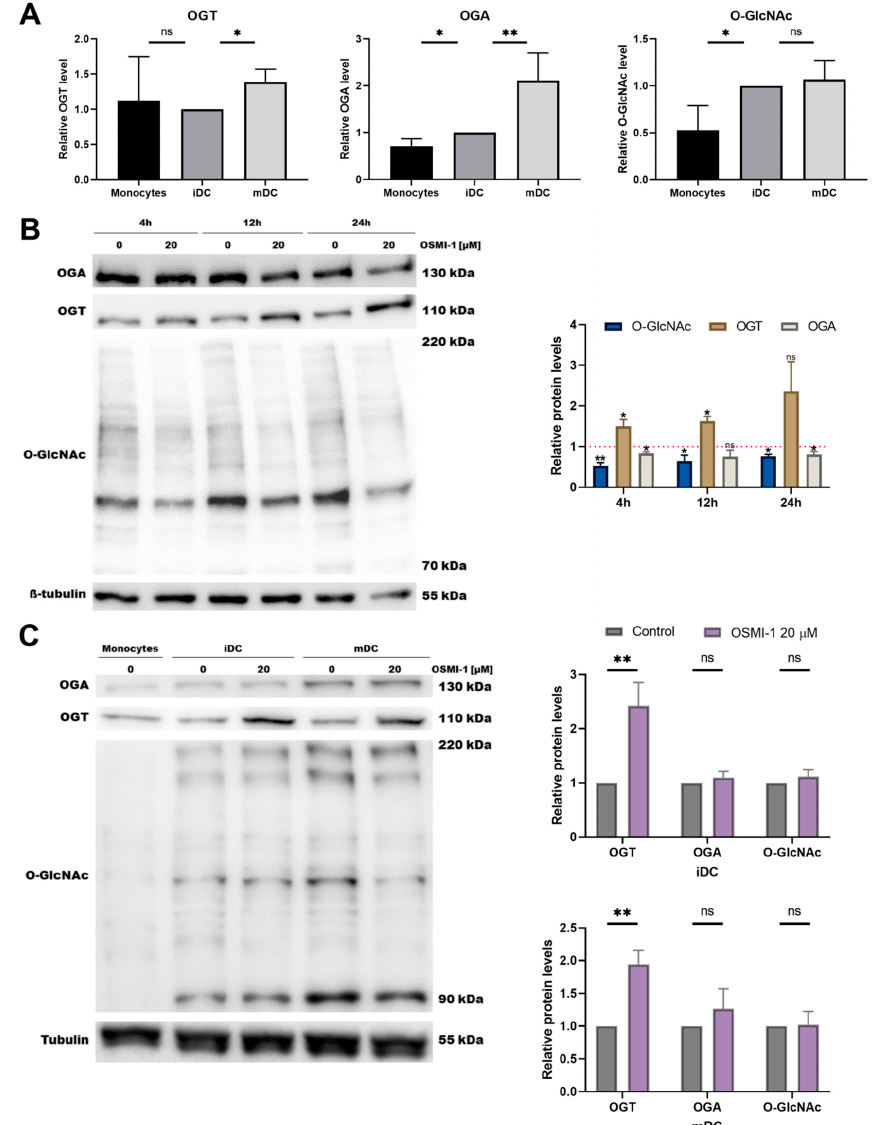
Figure 1. Protein levels of OGT, OGA and O-GlcNAcylated proteins. ( A ) Monocytes, immature and mature moDCs have distinct levels of OGT, OGA and O-GlcNAcylated proteins. Results are normalized to immature moDCs values and presented as relative protein expression ± SD (3–5 different donors). ( B ) Representative immunoblots for O-GlcNAcylated proteins, OGT and OGA in the presence or absence of 20 µ M OSMI-1. Samples were collected after 4, 12 or 24 h from the start of the differentiation process. ß-tubulin was used as the loading control. Results are presented as relative protein levels to untreated cells ± SD (3 different donors). ( C ) Representative immunoblots for O-GlcNAcylated proteins, OGT and OGA in monocytes and immature or mature moDCs prepared in the presence or absence of 20 µ M OSMI-1. Tubulin was used as the loading control. Results are presented as relative protein levels to untreated cells ± SD (4–5 different donors). Statistical significance between individual pairs was calculated using the ANOVA; p -value < 0.05 was considered statistically significant (* p < 0.05; ** p < 0.01; ns, nonsignificant). iDCs, immature moDCs; mDCs, mature